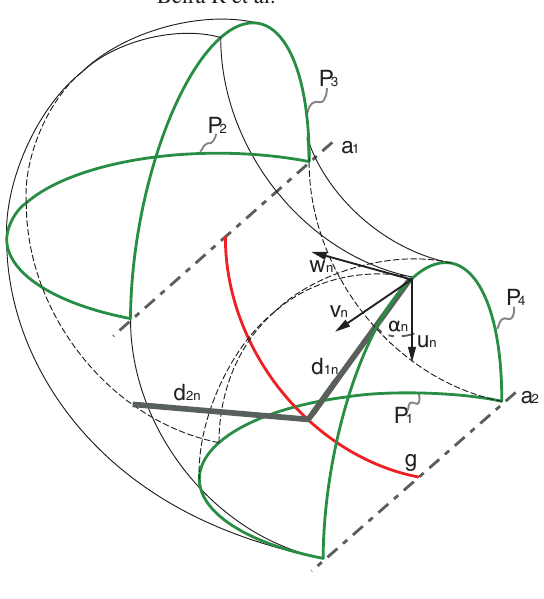
Fig. 12. Profiles generating the n th limb workspace.